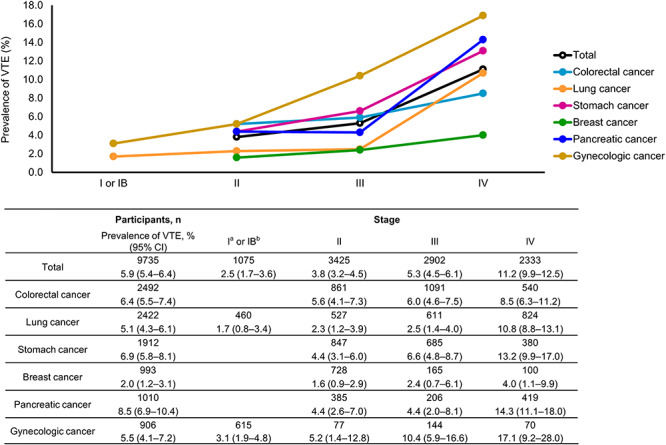
VTE prevalence by cancer type and stage. aGynecologic cancers only. bLung cancer only. Data in the table show the exact probability based on binomial distribution. CI, confidence interval.